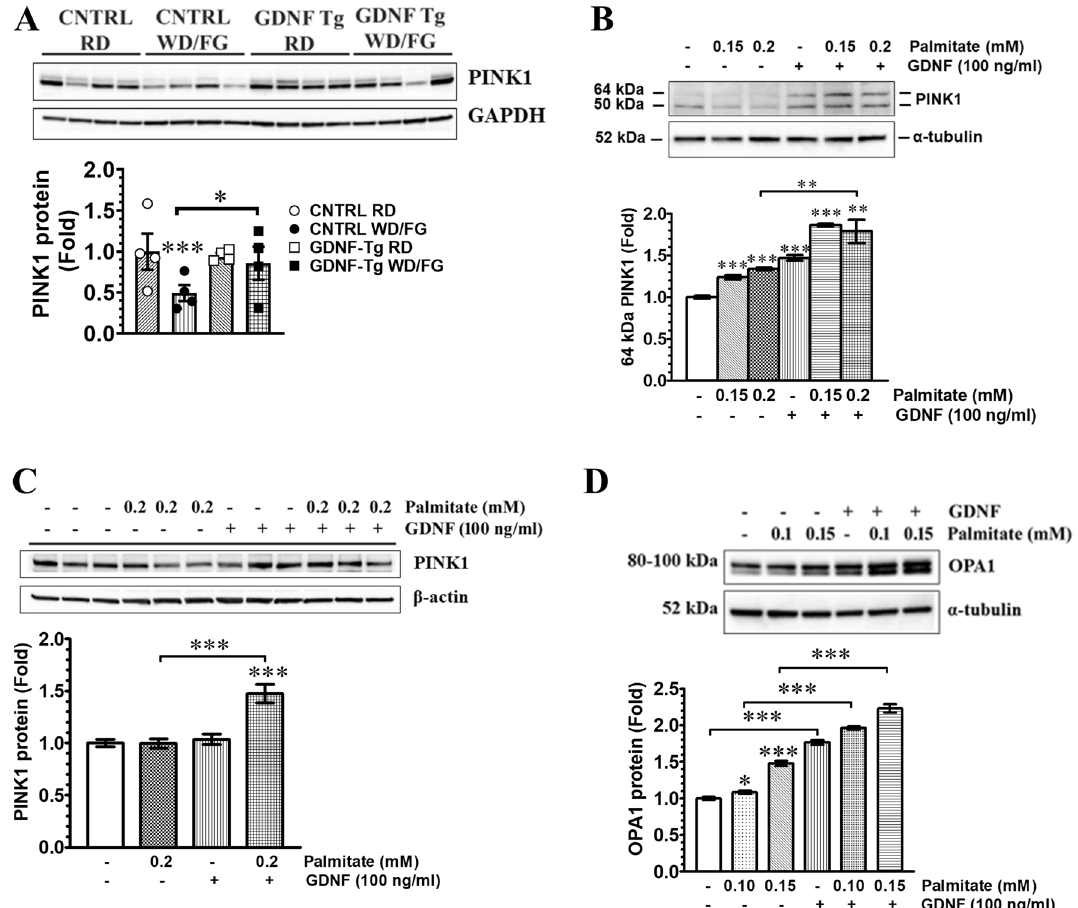
Figure 3. GDNF reverses Western diet-induced suppression of hepatic PTEN-induced putative kinase 1 (PINK1) levels. ( A ) Western blot analysis of hepatic PINK1 and GAPDH (loading control) protein levels in control (CNTRL) and GDNF transgenic (GDNF Tg) mice fed regular diet (RD) or Western diet with fructose and glucose in drinking water (WD/FG) for 25 weeks. The bands were cropped from the original blots presented in Supplementary Fig. S3. Plotted are means + SE. ***P < 0.001, relative to RD-fed control mice. N = 4 mice per group. ( B ). Western blot analysis of PINK1 and α-tubulin (loading control) protein levels in human hepatocytes exposed for 24 h to PA in the presence or absence of GDNF. The bands were cropped from the original blots presented in Supplementary Fig. S4. Plotted are means ± SE. ***P < 0.001; **P < 0.01, relative to vehicle and 0.2 mM PA + GDNF, respectively; N = 3. Western blot analysis of ( C ) PINK1 and β-actin (loading control) and ( D ) OPA1 and α-tubulin (loading control) protein levels in rat hepatocytes exposed to PA and GDNF for 24 h. The bands were cropped from the original blots presented in Supplementary Figs. S5 and S6. Plotted are means ± SE. ***P < 0.001, *P < 0.05, relative to Vehicle; N =